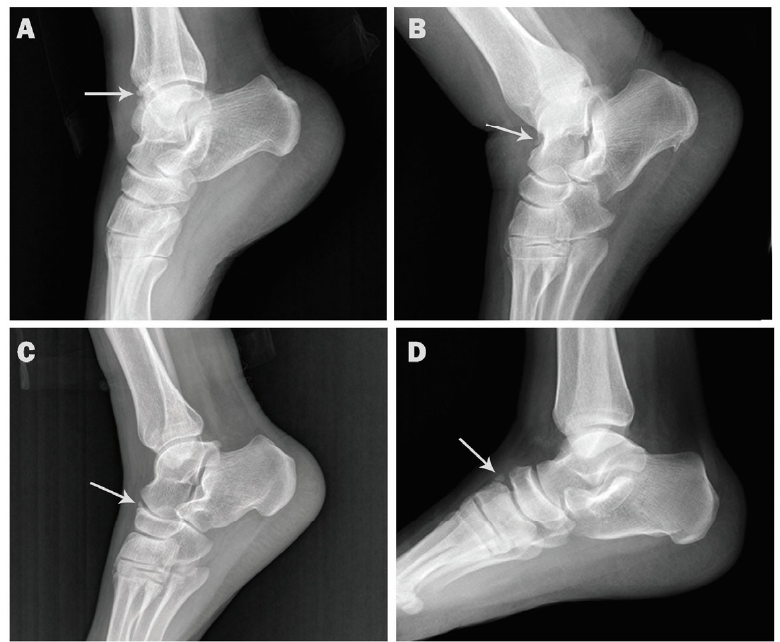
Figure 1. Lateral radiographs showing accessory ossicles (arrows). ( A ). Os talotibiale in a 38-year-old female. ( B ). Os supratalare in 47-year-old male. ( C ). Os supranaviculare in 51-year-old male. ( D ). Os infranaviculare in 25-year-old male.